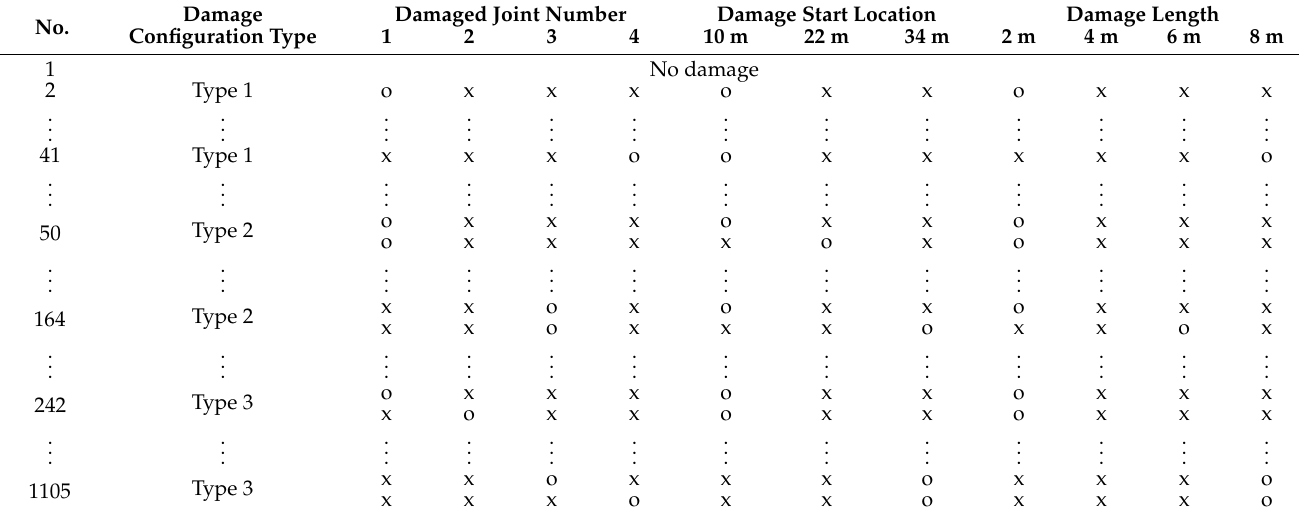
Table 2. Debonding damage configuration.